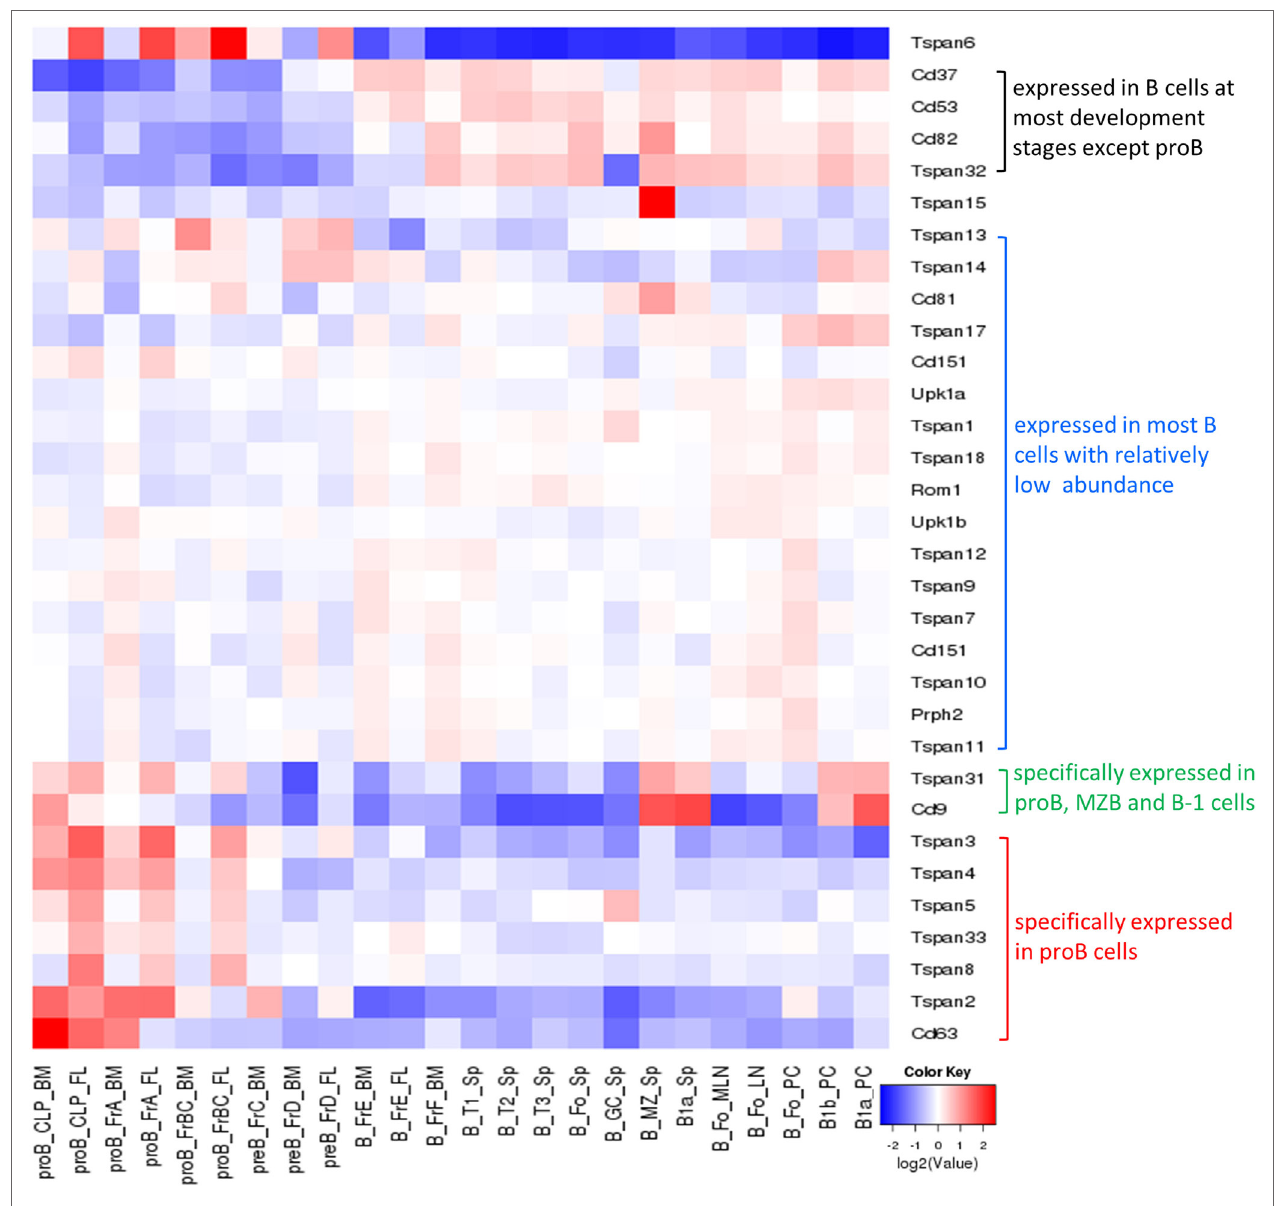
FiGURe 4 | Expression of tetraspanins in murine B cell subsets. The heat map was obtained from http://www.immgen.org/by inputting the list of tetraspanins in “My GeneSet” and choosing B cells as the populations of interest. The gene expression level is determined by Affymetrix microarrays (GEO: